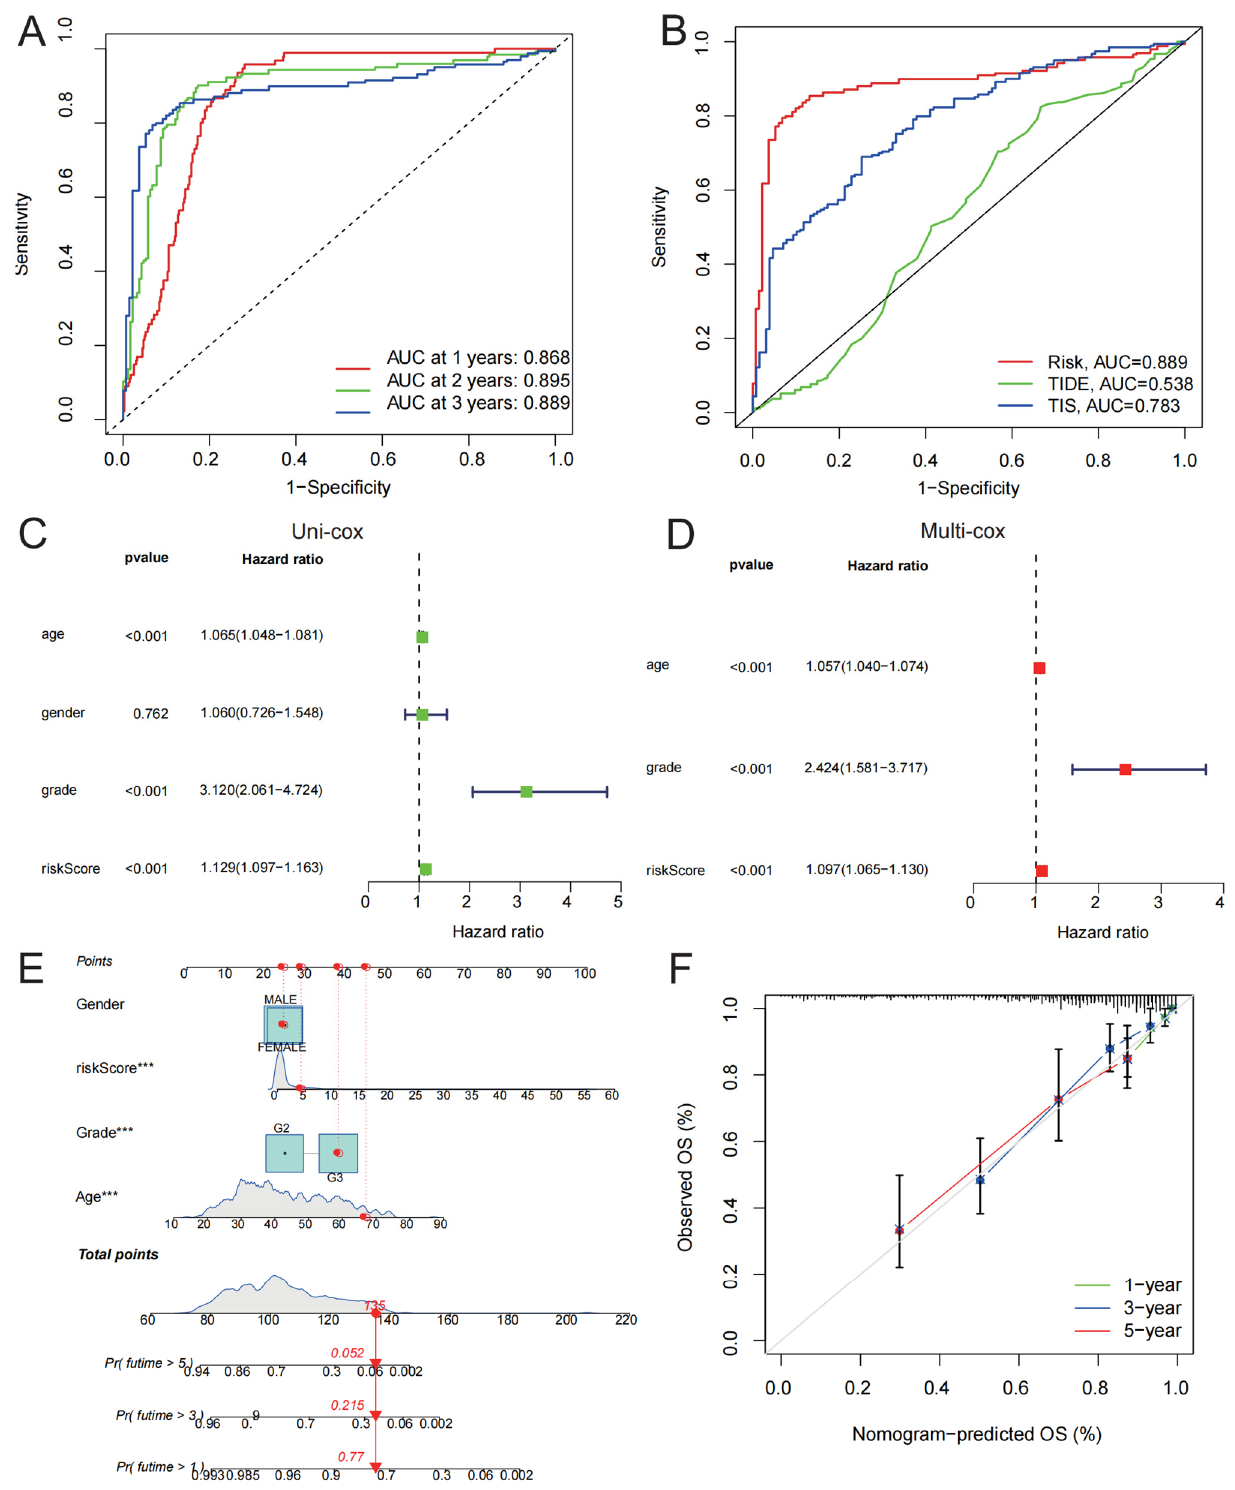
Figure 7. Prognostic value of IGRPS. ( A ) ROC curve for predicting the 1-, 2-, and 3-year survival rates in gliomas. ( B ) ROC curve for predicting the 3-year survival rates in glioma compares predictive power of IGRPS, TIDE, and TIS. ( C ) Univariate independent prognostic analysis of IGRPS. ( D ) Multivariate independent prognostic analysis of IGRPS. ( E ) Nomogram formed by integrating IGRPS and clinicopathological features predicts the glioma prognosis. ( F ) The calibration curve evaluates the accuracy of nomograms for predicting the prognosis of gliomas. *** p <